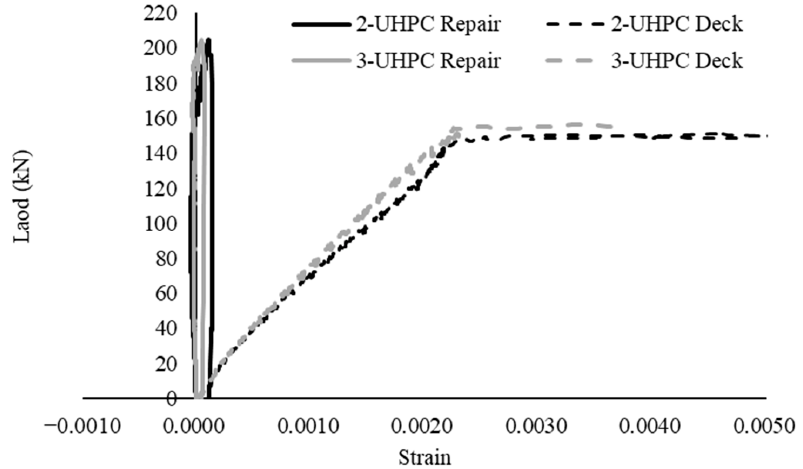
Figure 14. Load vs. strain plot for connected girder specimens repaired with UHPC.